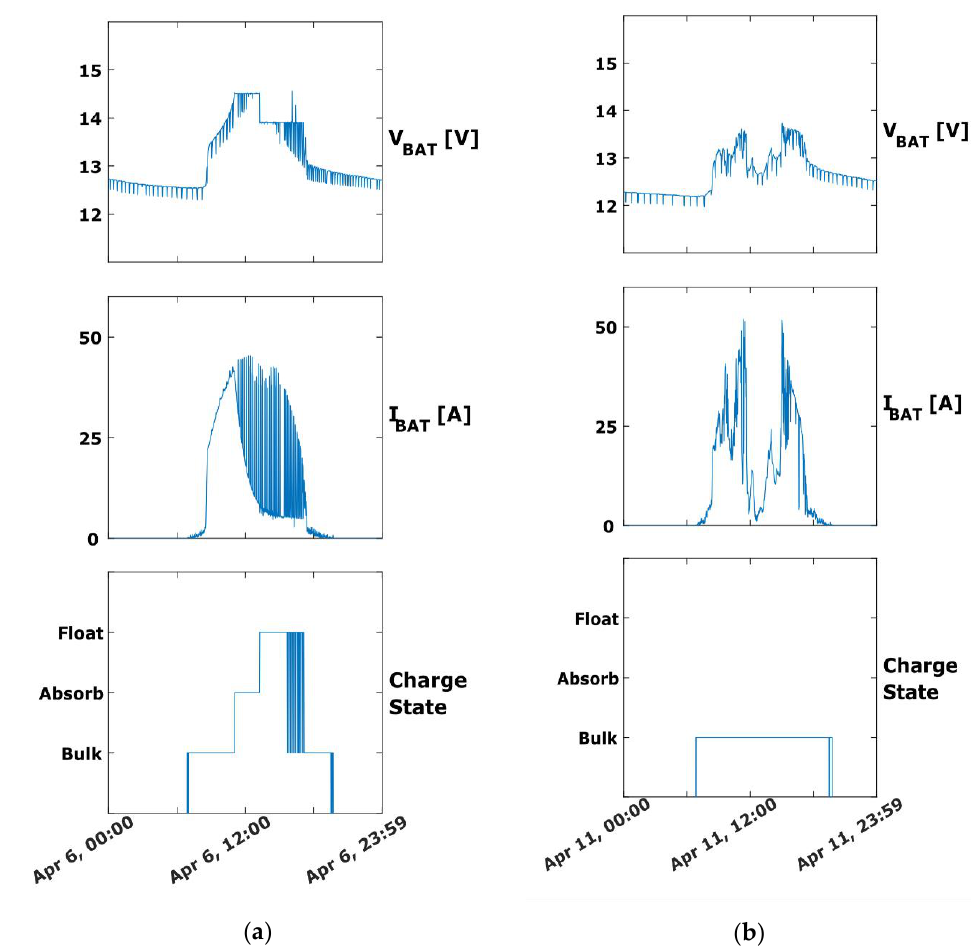
Figure 14. MPPT solar charge controller displaying behavior under favorable weather conditions on 6 April ( a ) and under unfavorable conditions on 11 April ( b ).